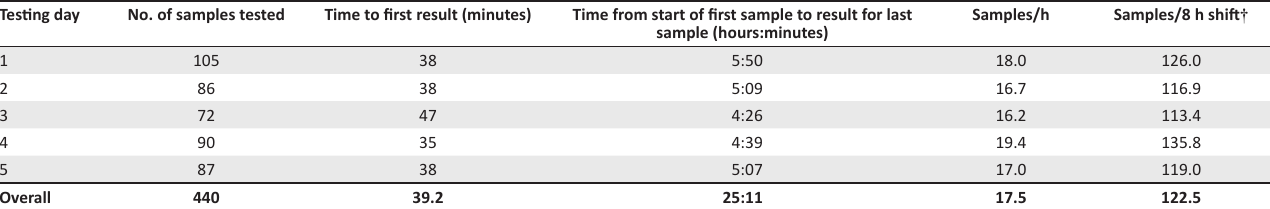
TABLE 6: High volume workflow results with AQUIOS PanLeucogating, South Africa, February 2015. Testing day No. of samples tested Time to first result